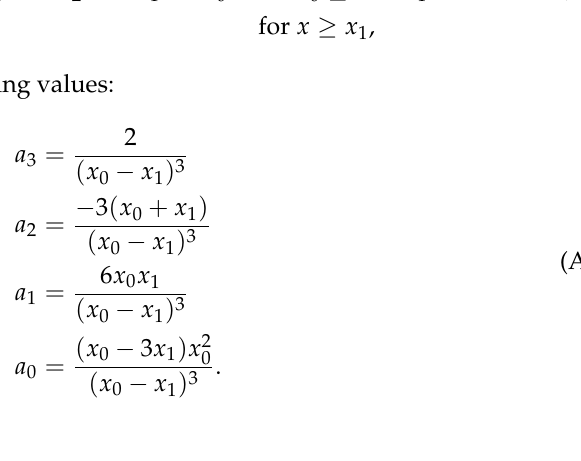
Table A1 lists the abbreviations used in this work. Table A1. Abbreviations used in this